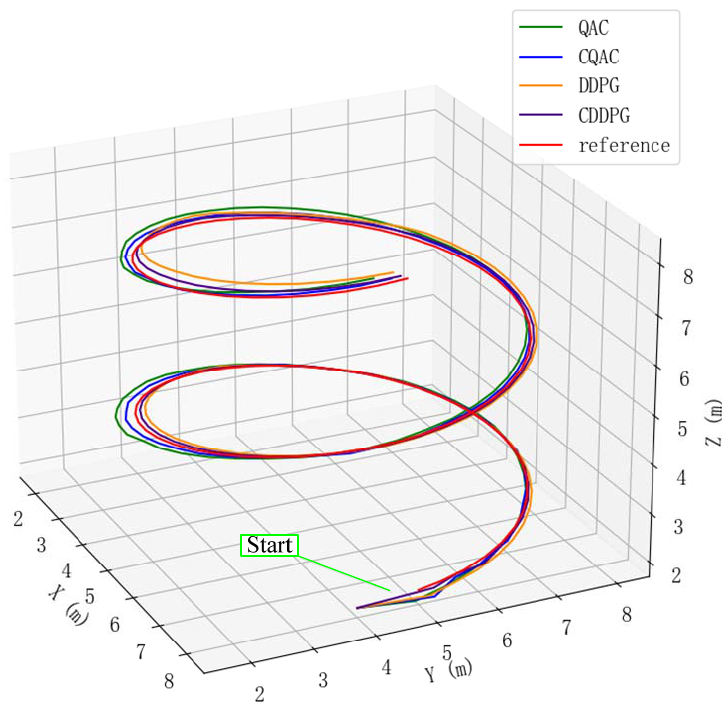
Figure 10. Spiral trajectory tracking curve of four